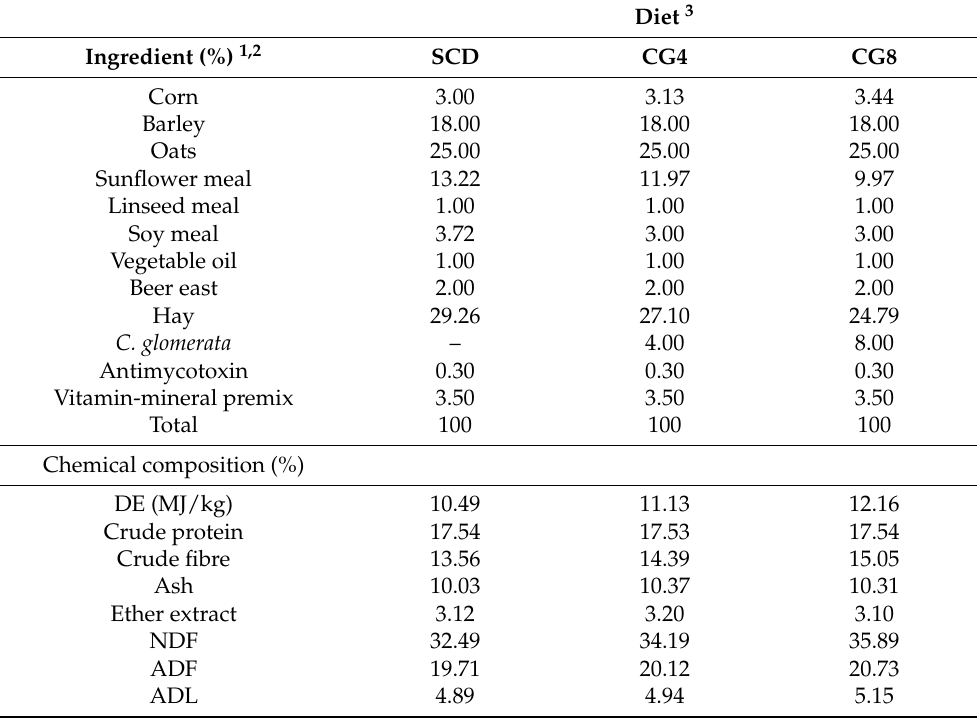
Table 1. Ingredients in rabbit feed and chemical composition of a standard compound diet and diets supplemented with different dosages of C. glomerata biomass (52–122 days